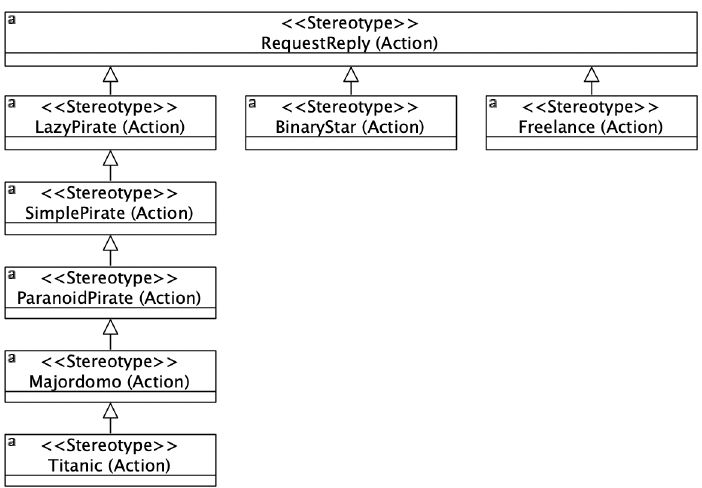
Figure 5. ZeroMQ stereotypes for patterns that inherit from the EIP Request–Reply